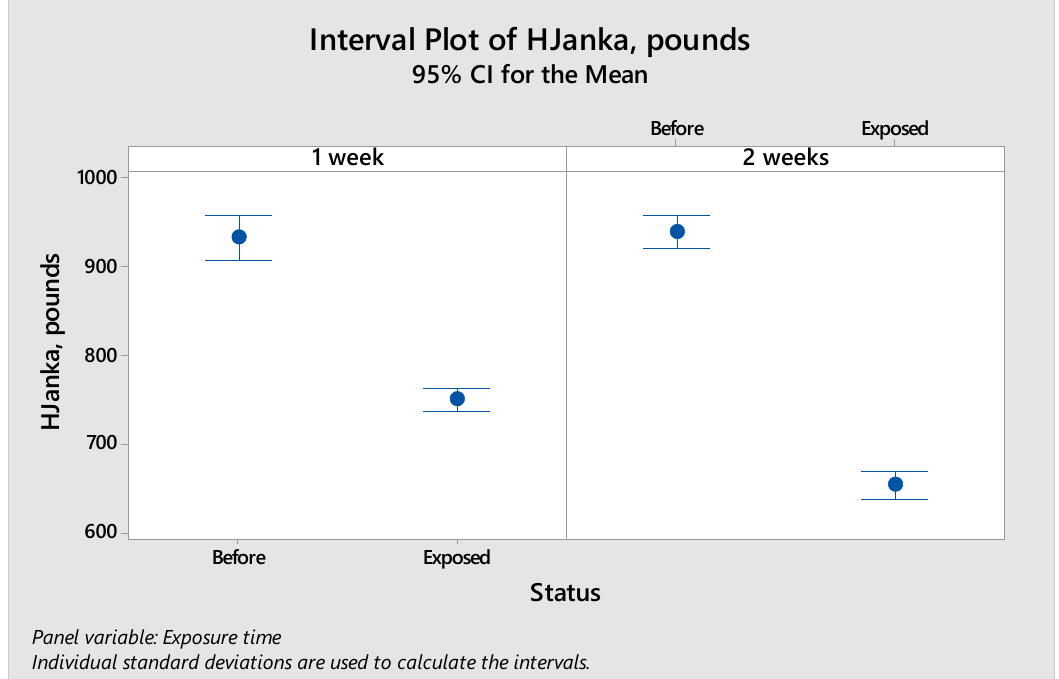
Figure 8. Variation of the Janka hardness of the overlaid PB samples, before and after exposure to humidity conditions.